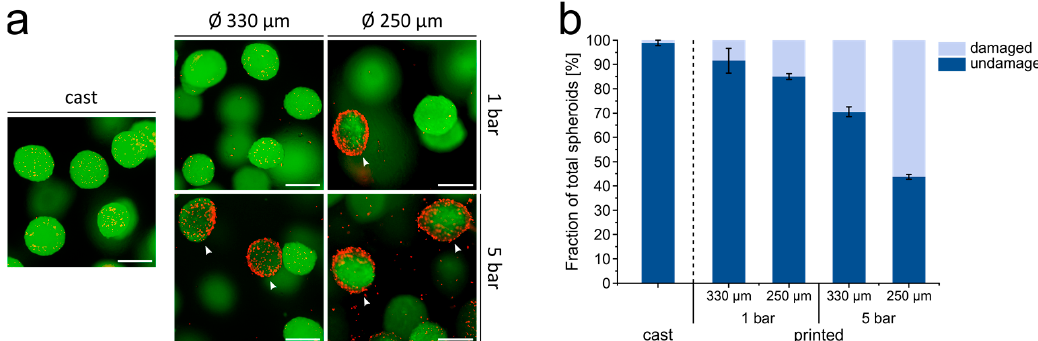
Figure 3. Influence of different printing parameters on the viability of ASC spheroids. ( a ) Live/dead staining of ASC spheroids either cast or printed with different printing pressure (1 and 5 bar) and different inner nozzle diameter (250 µm and 330 µm). Living cells are labeled green (calcein-AM), and dead cells are labeled red (EthD-III). White arrowheads indicate dead cells in the outer cell layer of the spheroids. Scale bars represent 200 µm. ( b ) Quantification of damaged and undamaged ASC spheroids after casting or printing under different conditions. Data are presented as mean ± standard deviation ( n = 3 gels, with >80 spheroids each). All groups were statistically significantly different from each other ( p < 0.05).